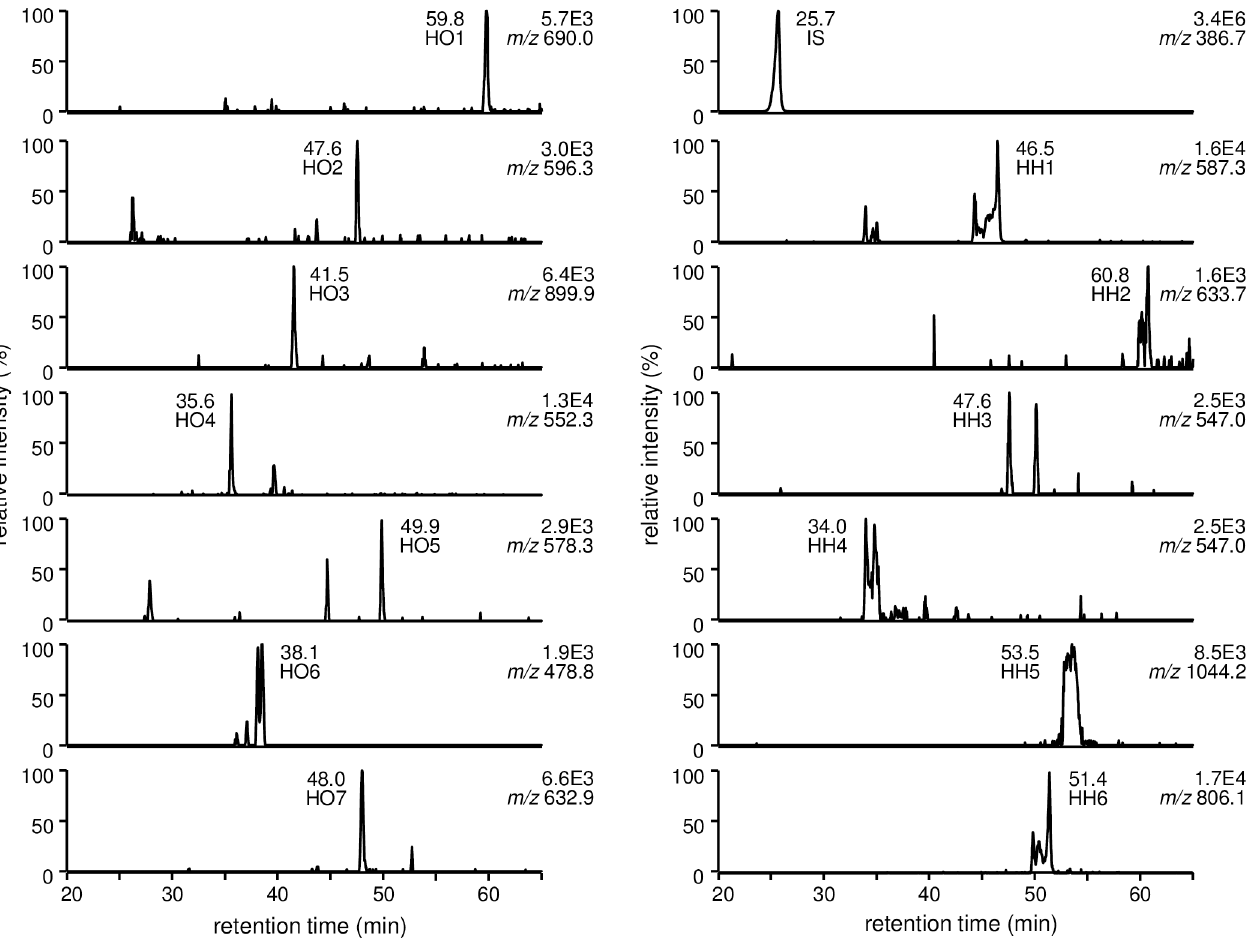
Fig 8. LC/ESI-MS analysis of IS and selected ONE/HNE-modified HSA peptides in the reaction between HSA and 13-HPODE in the presence of AscA and PM.